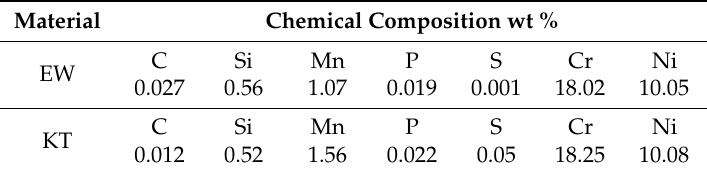
Table 1. Chemical compositions of the tested materials.